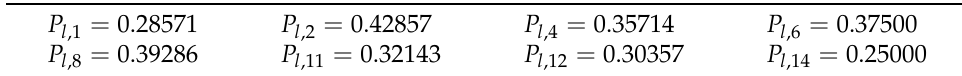
Table 2. IEEE 14-bus power loads